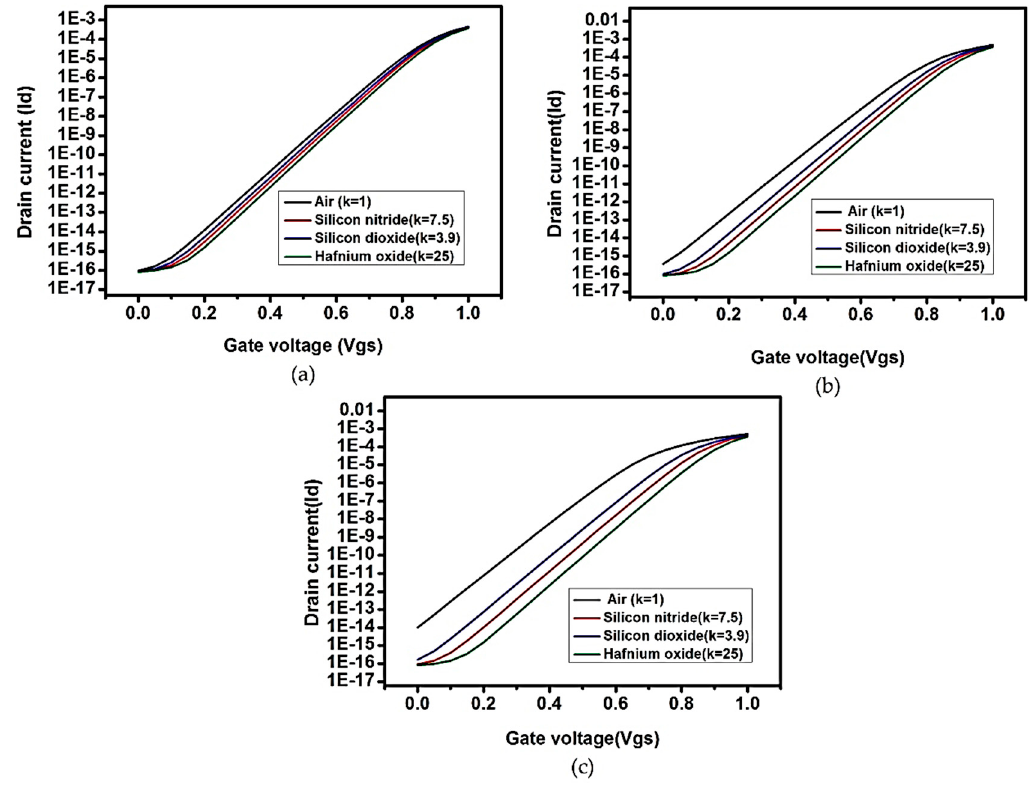
Figure 6. Drain current versus gate voltage curve, with ( a ) air (K = 1) as the dielectric material; ( b ) silicon nitride (K = 7.5) as the dielectric material; ( c ) silicon dioxide (K = 3.9) as the dielectric material.